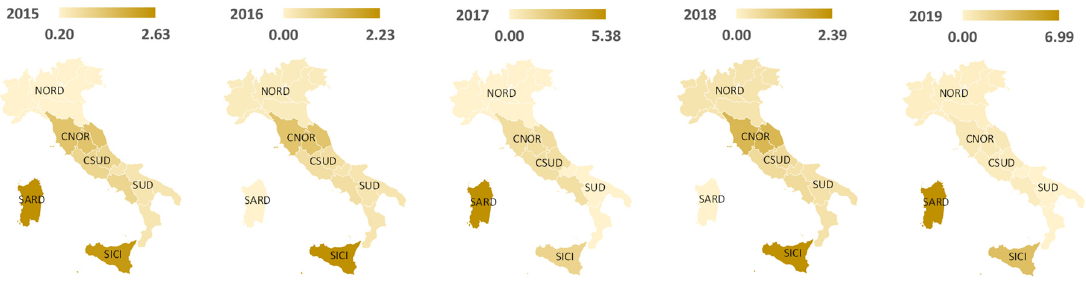
Figure 9. A 100 MW increase in solar generation in each zone; impact on electricity price in the same zone ( €/MWh ); 2015 – 2019.